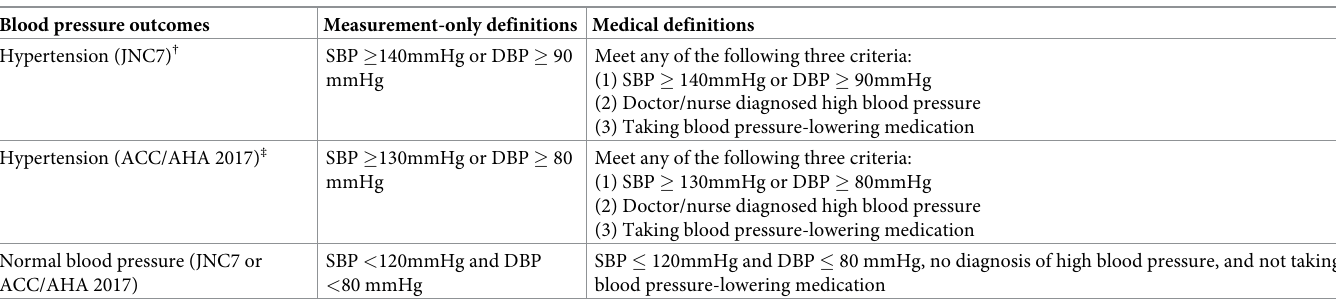
Table 1. Definitions of blood pressure outcome used in the study. Blood pressure